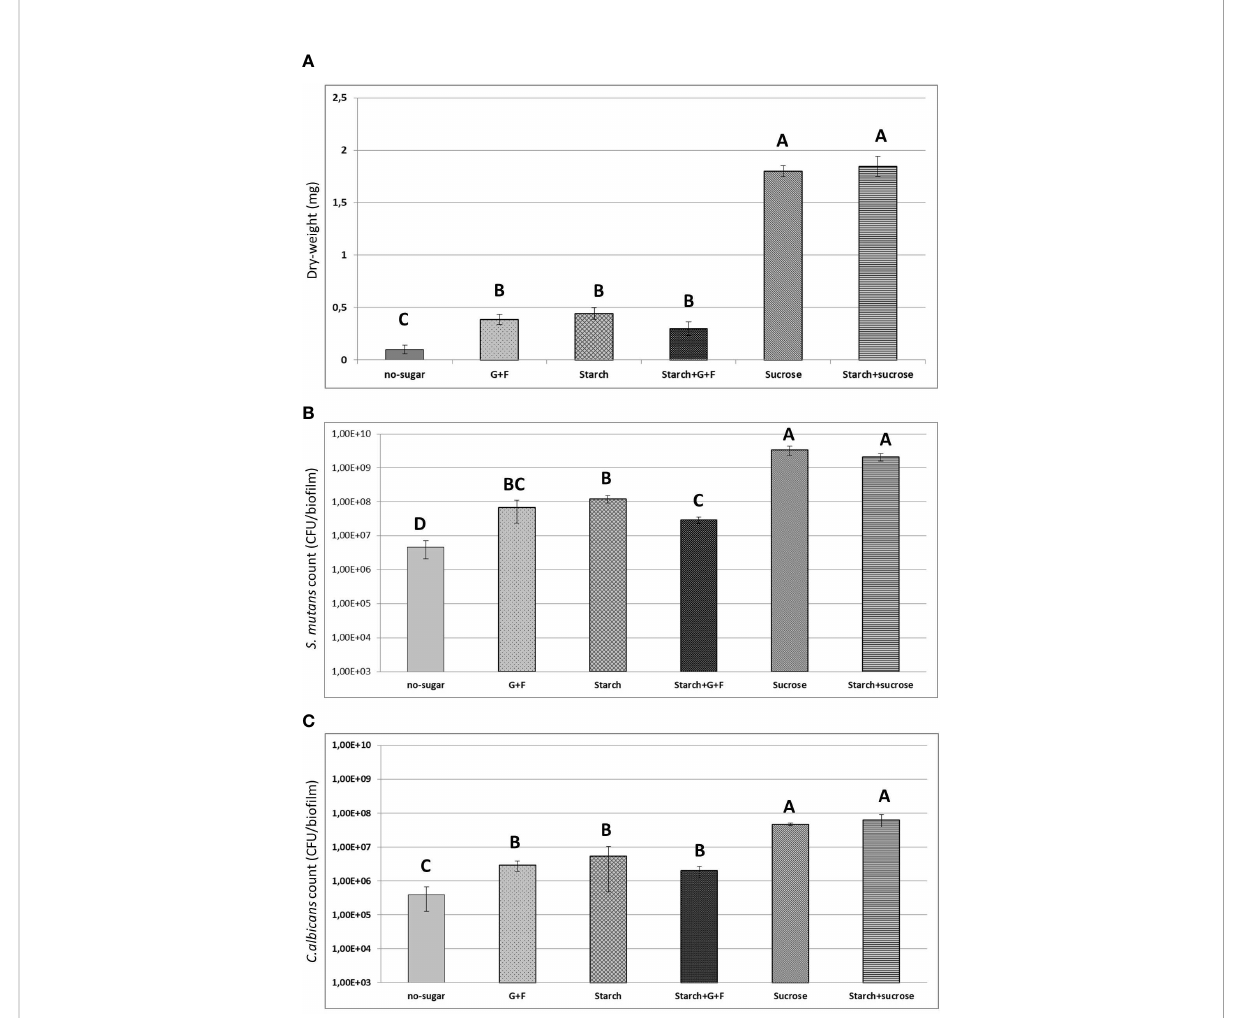
FIGURE 4 Results of biochemical and microbiological assays. (A) Total biomass (measure as dry-weight in mg) of 19h bio fi lms originated from different sugar-mediated aggregates. (B) Counts of S. mutans (CFU) within the bio fi lms (C) Counts of C. albicans (CFU) within the bio fi lms. Bars denote the mean and vertical lines denote standard deviation. G+F: glucose+fructose. Groups with distinct capital letter are statistically different (p<0.05 by one-way ANOVA with Tukey test)" by: Groups whose means are followed by different upper case letters differ statistically by ANOVA followed by Tukey test